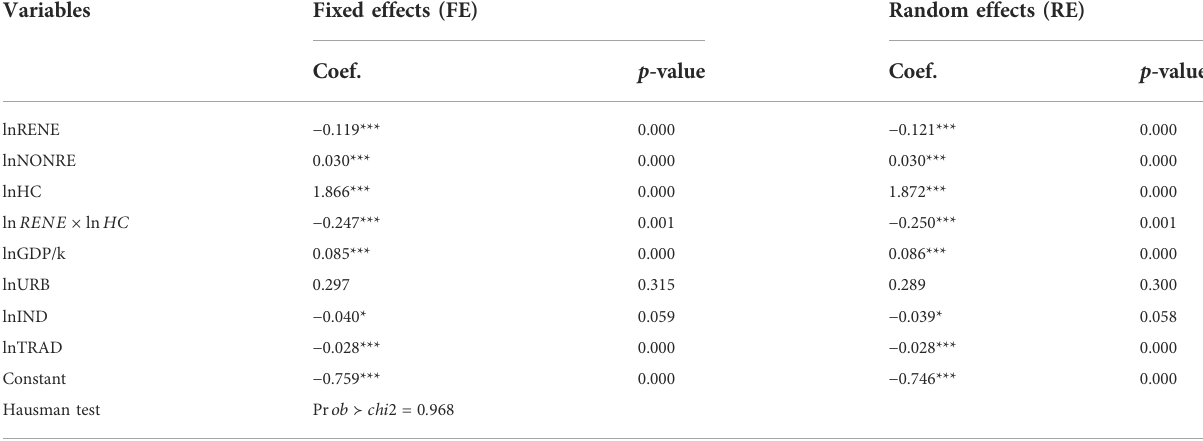
TABLE 12 Results of the moderating effect of human capital on the renewable energy-CO2 emissions nexus using the FE and RE estimators. Variables